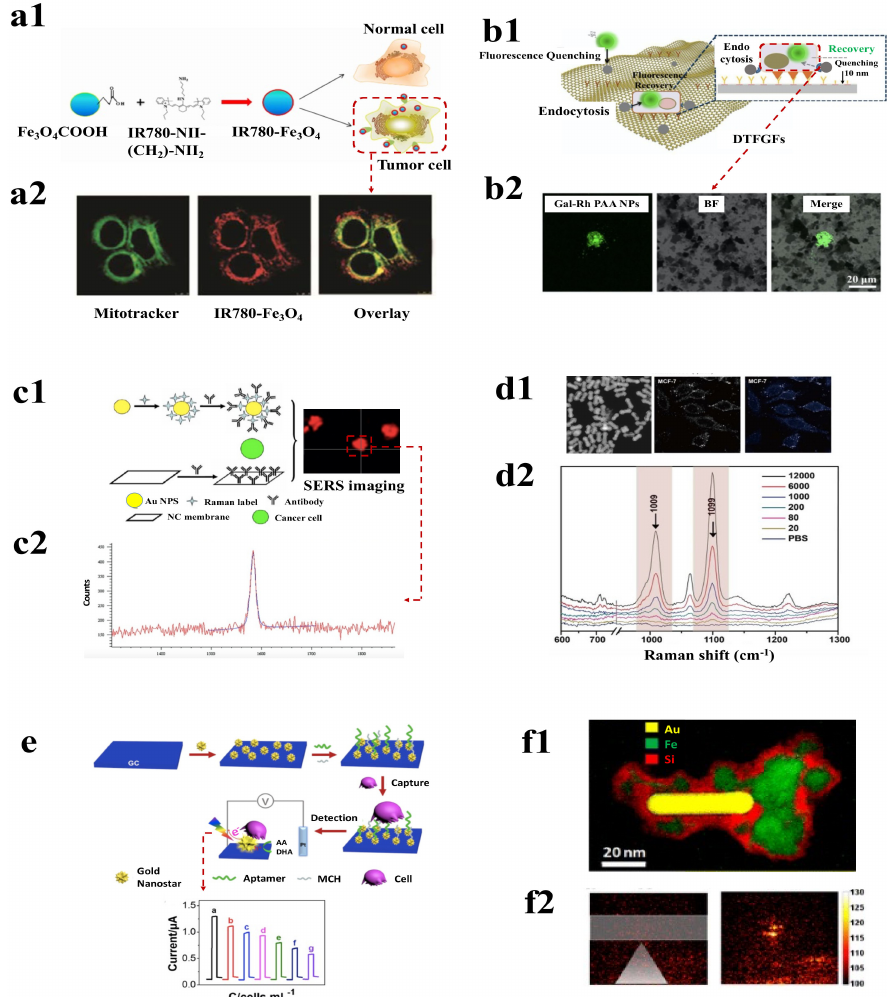
Figure 5. The different strategies for the detection of CTCs using NPs (part-I). ( a1 ) Demonstrates the process of self-engulfing of the fluorescent magnetic IR780-Fe 3 O 4 NPs whereas ( a2 ) shows the specific localization of the NPs in the mitochondria of the CTCs. Reprinted with permission from [146]. Copyright 2017 Elsevier. ( b1 ) The scheme of fluorescence detection of CTCs along with ( b2 ) highlighting the fluorescence activation in the cancer cells. Reprinted with permission from [150]. Copyright 2019 American Chemical Society. ( c1 , c2 ) Shows the scheme of Au NPs functionalization followed by the capture of CTCs for SERS imaging along with the Raman spectra of a single cell. Reprinted with permission from [58]. Copyright 2014 American Chemical Society. ( d1 ) Left sub-panel shows the TEM image of the nanorods whereas the middle and right sub-panels show the interaction between the nanorods and MCF-7 cells. The increase in SERS signal with the rise in cancer cell number as detected by this system has been depicted in ( d2 ). Reprinted with permission from [151]. Copyright 2017 American Chemical Society. ( e ) Schematic representation of CTCs detection by the DPEE mechanism. The increase in cells concentration results in a decrease in current as detected by the potentiometer (a–g: 0, 5, 50, 1 × 10, 1 × 10, 1 × 10, 1 × 10 cells/mL respectively). Reprinted with permission from [152]. Copyright 2019 American Chemical Society. ( f1 ) Shows the iron oxide NP within silica nanostructure with the three main components: Au (yellow), Fe (green) and Si (red). ( f2 ) The positions of the capillary and permanent magnet are indicated in the left sub-panel whereas the photoacoustic signal of labelled HeLa cells accumulated in the detection area in the right sub-panel. Reprinted with permission from [153]. Copyright 2018 Springer